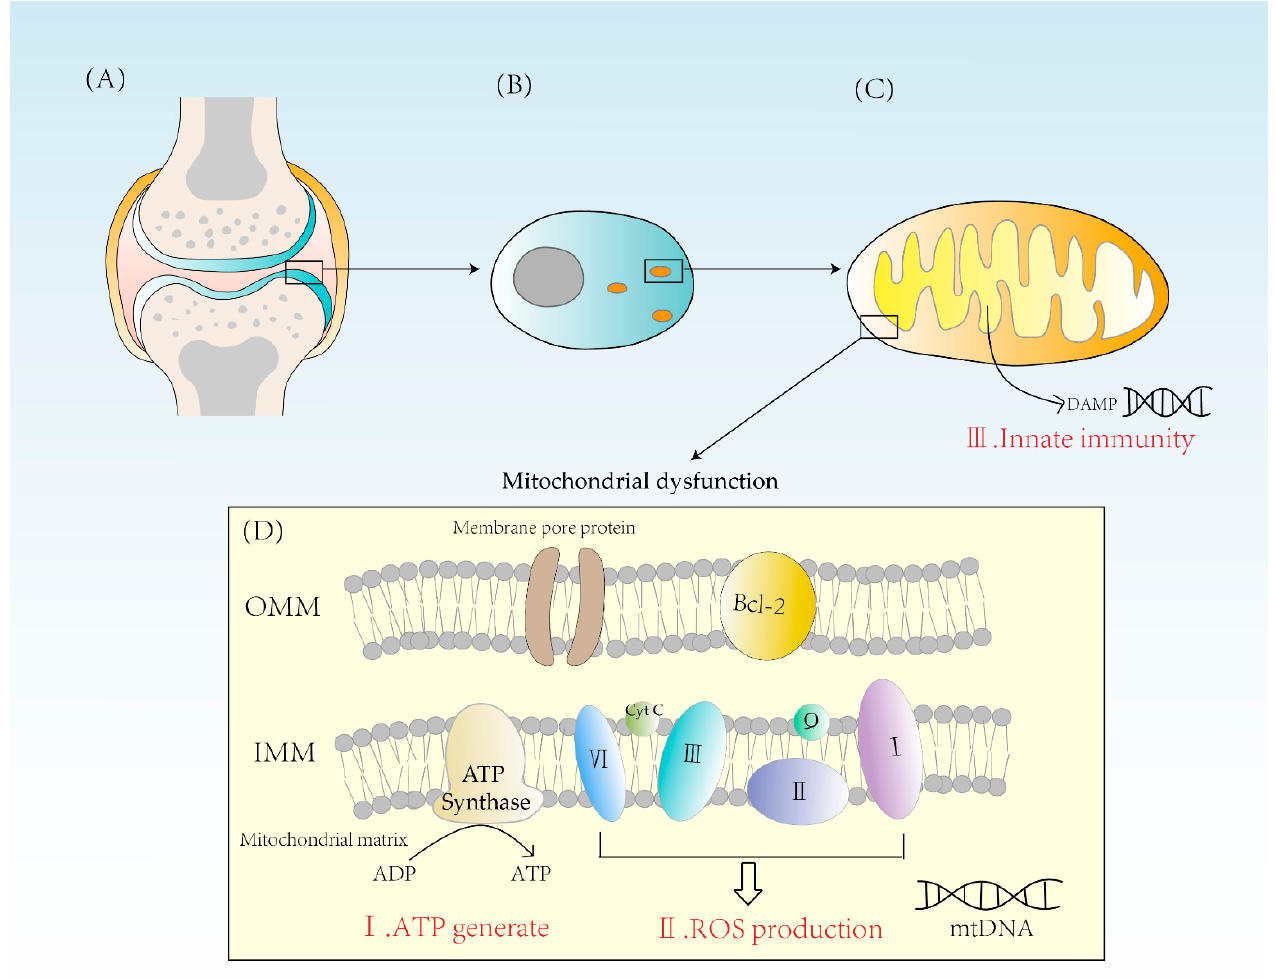
Figure 1. ( A ) A diagram of the articular cartilage structure. Cartilage is mainly composed of chon- drocytes. ( B ) The distribution of mitochondria in chondrocytes is related to the energy requirement. ( C ) Mitochondrion is a double-membrane organelle. Mitochondria have two membranes, an outer membrane and an inner membrane. Mitochondrial inner membrane folds to form cristae. The mitochondrial matrix contains mtDNA. DAMPs activate innate immunity, causing inflammatory reactions. ( D ) Mitochondria synthesize ATP through ATPase and form ROS through complexes I, II, III, and IV. When mitochondria are dysfunctional, both excessive ROS and energy imbalance will con- tribute to the occurrence of RA. OMM = outer mitochondrial membrane, IMM = inner mitochondrial membrane, Bcl-2 = B-cell leukemia/lymphoma-2, DAMPs = damage-associated molecular patterns.